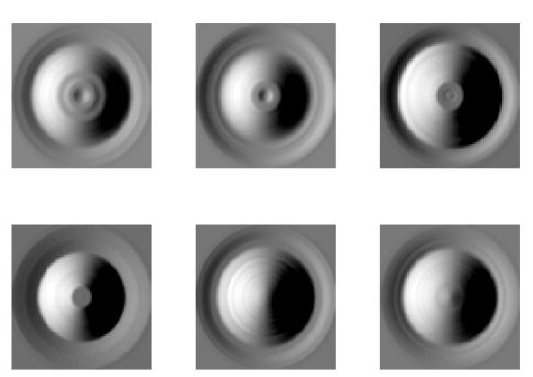
Figure 1. Set of six rendered crater templates used for template matching, given typical illumination